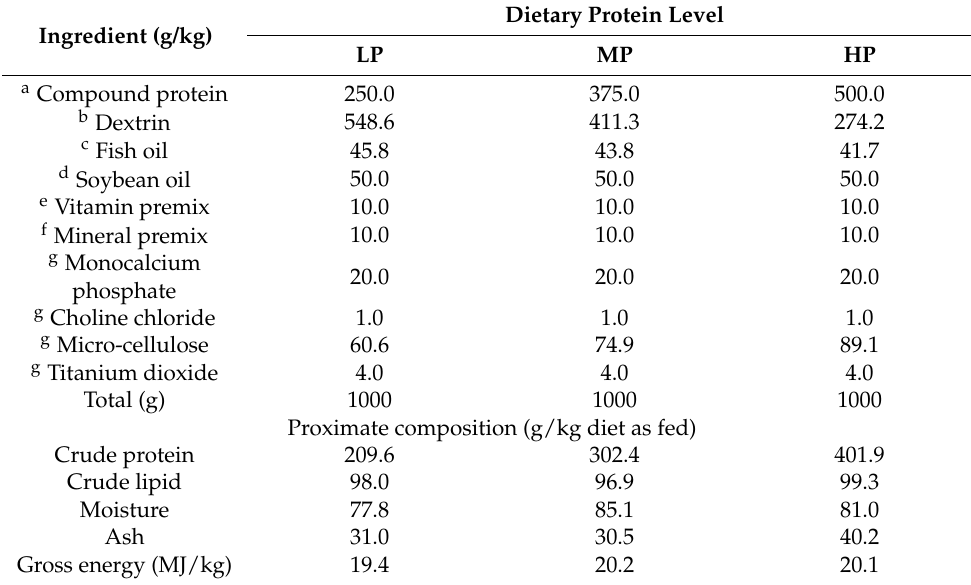
Table 1. Formulation and proximate composition of the experimental